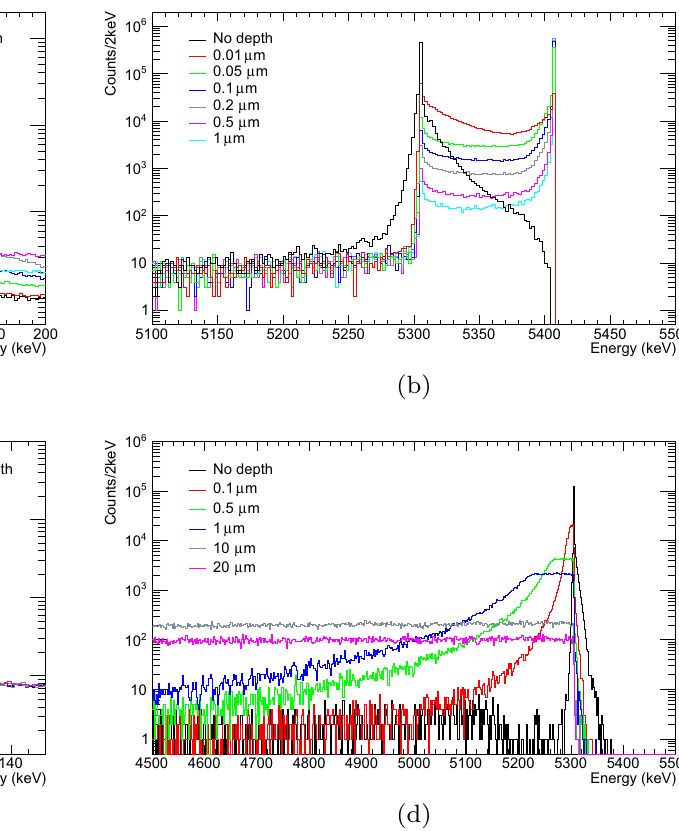
Fig. 7 a Low- and b high-energy spectra from surface 210 Pb contam- inants distributed uniformly within various surface depths of a crystal. The Q-value peak at 5407.5 keV that is the sum of 5304.3 keV α and 103.2 keV 206 Pb recoil is affected by energy loss depending on the crystal surface depth. c Low- and d high-energy spectra from surface